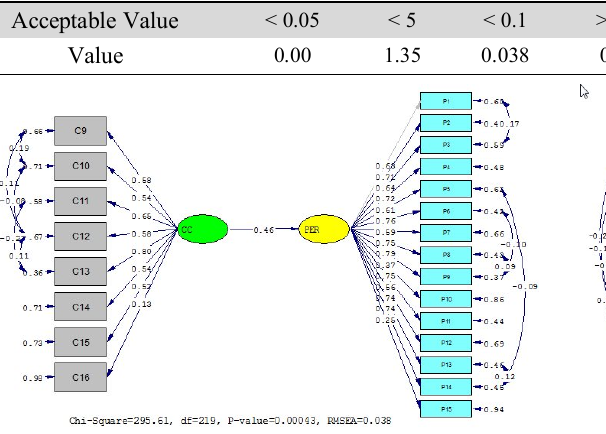
Fig. 4. The model 3 in the standard estimation state Fig. 5. The model 4 in the standard estimation state